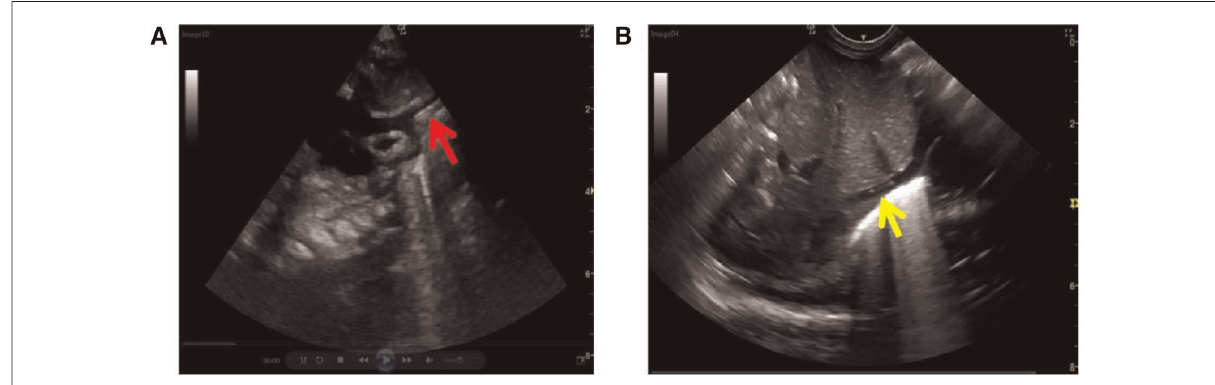
FIGURE 1 PICC ultrasonic imaging of vena cava. ( A ) superior vena cava (red arrow), and ( B ) inferior vena cava (yellow